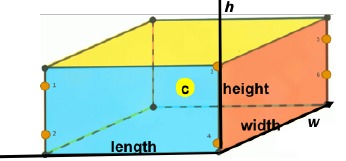
Figure 8. Rectangular beam description by central point, extensions, and directions.